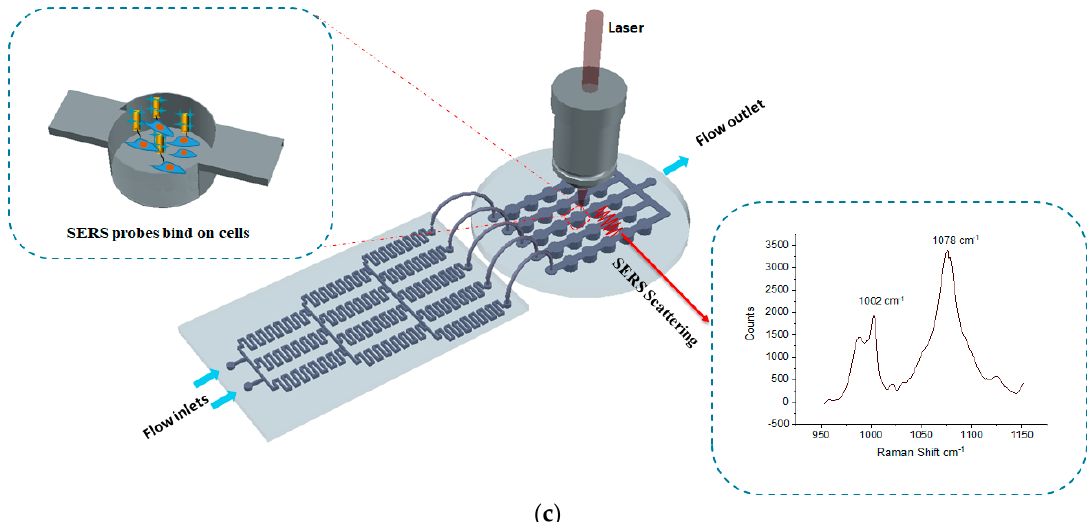
Figure 1. Fabrication steps of the microfluidic device and the experimental measurement setup. ( a ) Concentration gradient generator (CGG) part fabrication procedure. ( b ) Micro-well array part fabrication procedure. ( c ) Schematic of the experimental setup detection GPR120 receptors using surface-enhanced Raman spectroscopy (SERS).